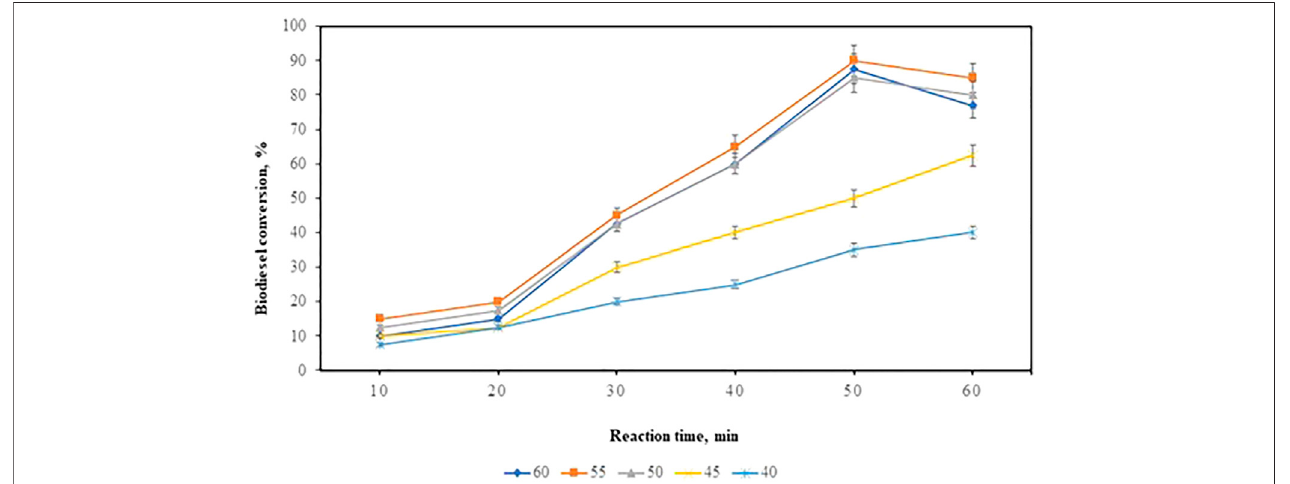
FIGURE 8 | Effect of reaction time and temperature on biodiesel production.